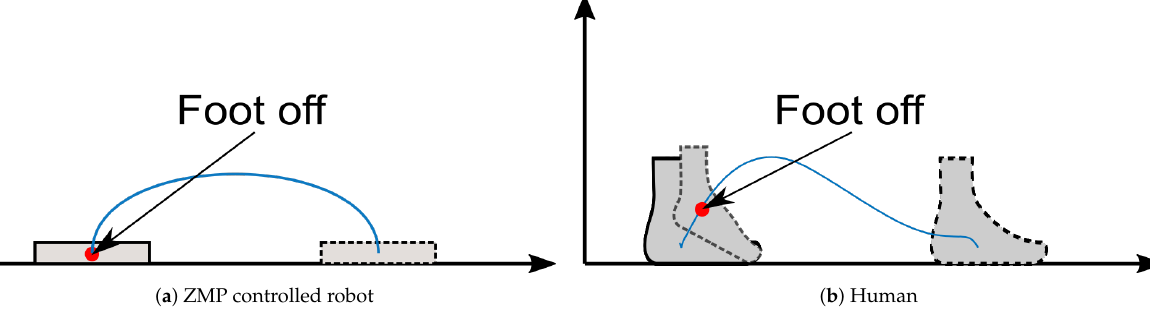
Figure 1. Swing leg’s foot trajectory of ( a ) robot and ( b ) human during gait cycle. Robot’s trajectory is from pre-developed robot [25]. Human gait is running at 3.56 m/s